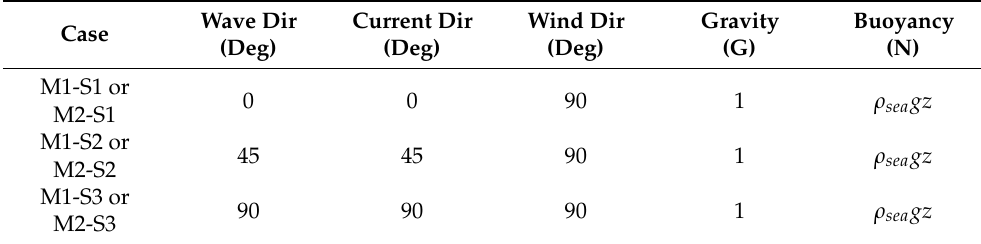
Table 8. Cases for structural frequency response